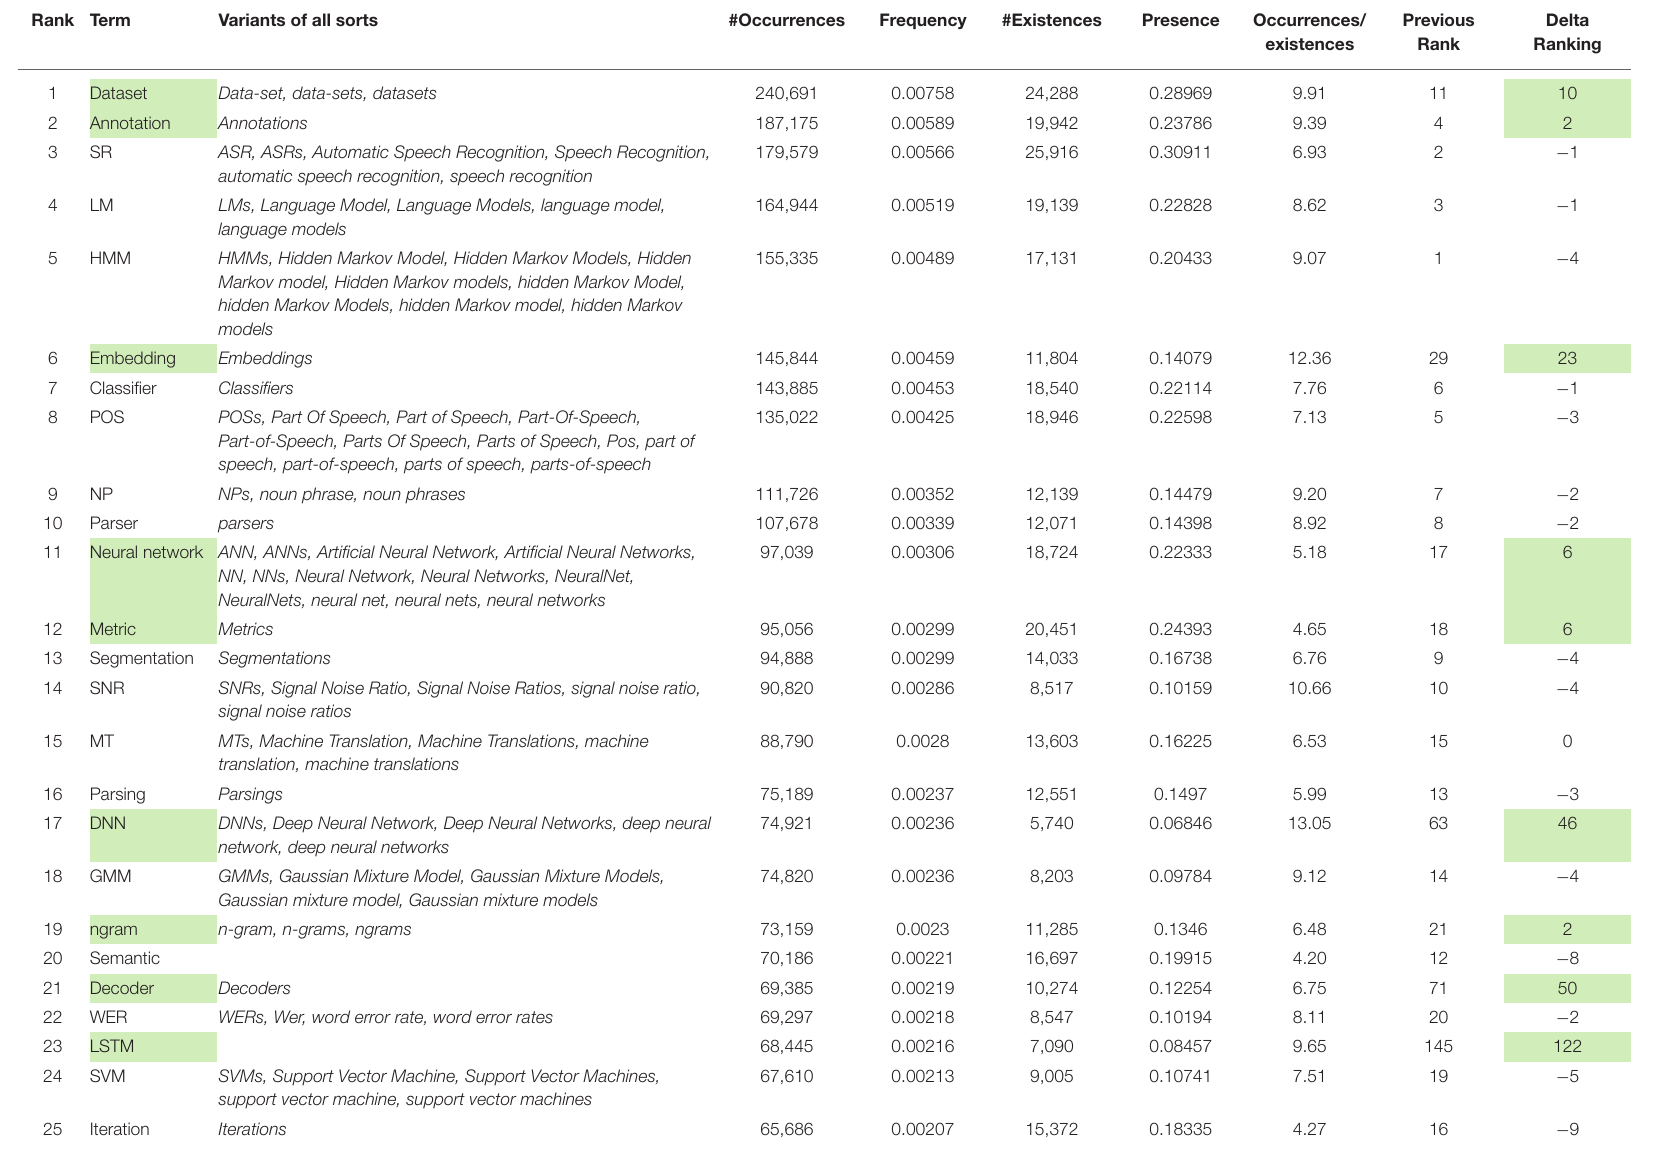
TABLE 21 | The number of 25 most frequent terms up to 2020 overall, with number of occurrences and existences, frequency and presence, in comparison with 2015 (terms marked in green are those which progressed in